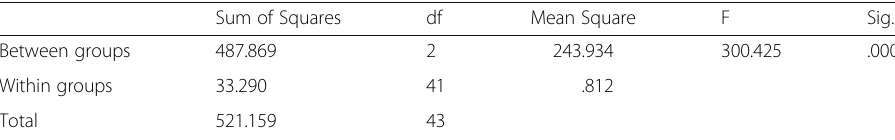
Table 5 One- way ANOVA on the groups ’ performance on the MKT as post-test Sum of Squares df Mean Square F Sig. Between groups 487.869 2 243.934 .000 Within